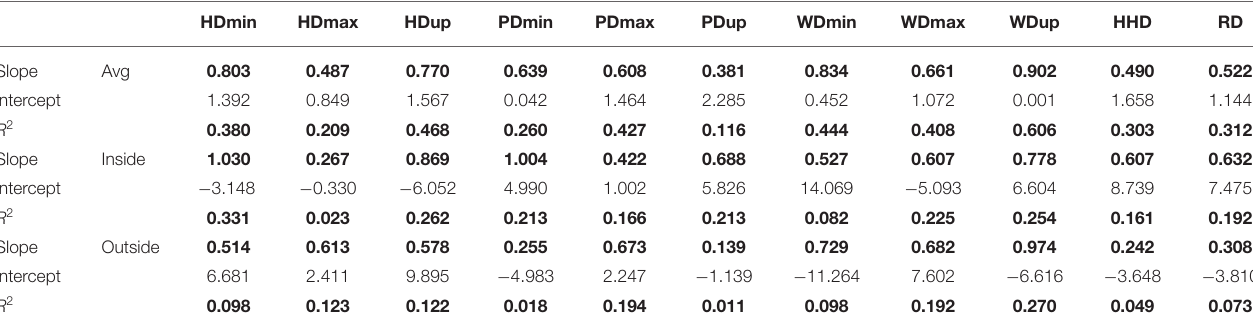
TABLE 2 | Slope, intercept, and R 2 values of linear fits to scatter plots of straight-line movement asymmetry values on x-axis and matching average-rein asymmetry values (avg), inside rein asymmetry values (inside), and outside rein asymmetry values (outside) on y-axis ( N = 79 assessment conditions from N = 26